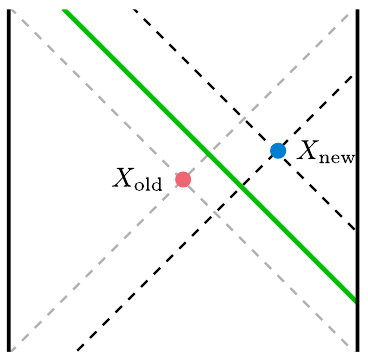
Figure 2 . After the evaporation of the right CFT R into the left L , the quantum extremal surface moves in a spacelike direction towards the right boundary from X old to X new . A message sent into R in the past will escape the new entanglement wedge of R and enter that of L